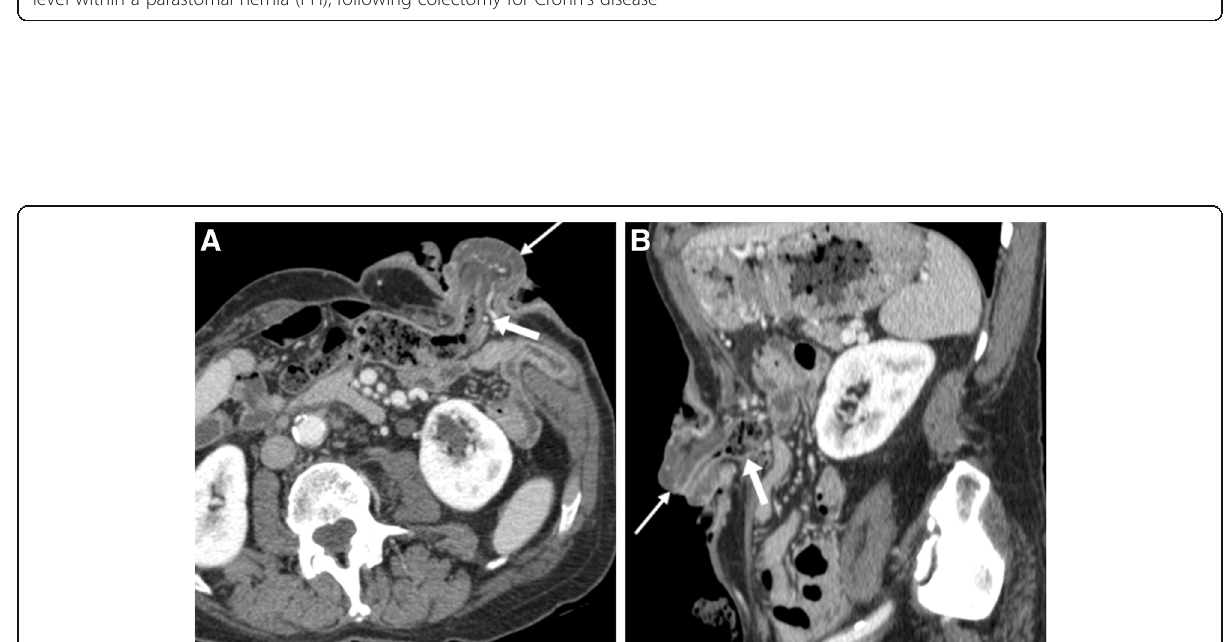
Fig. 10 Three cases of stomal abscesses, all of which required surgical treatment. a , b Ill-defined collection (+) with mixed fluid and air content occupying the subcutaneous fat at the site of a recent ileostomy (arrow in a ). c Large fluid collection (+) with thin walls abutting the lateral aspect of the ileostomy (arrow), following recent anterior rectal resection. d - f A typical abscess (+) with thickened enhancing walls and air-fluid level within a parastomal hernia (PH), following colectomy for Crohn ’ s